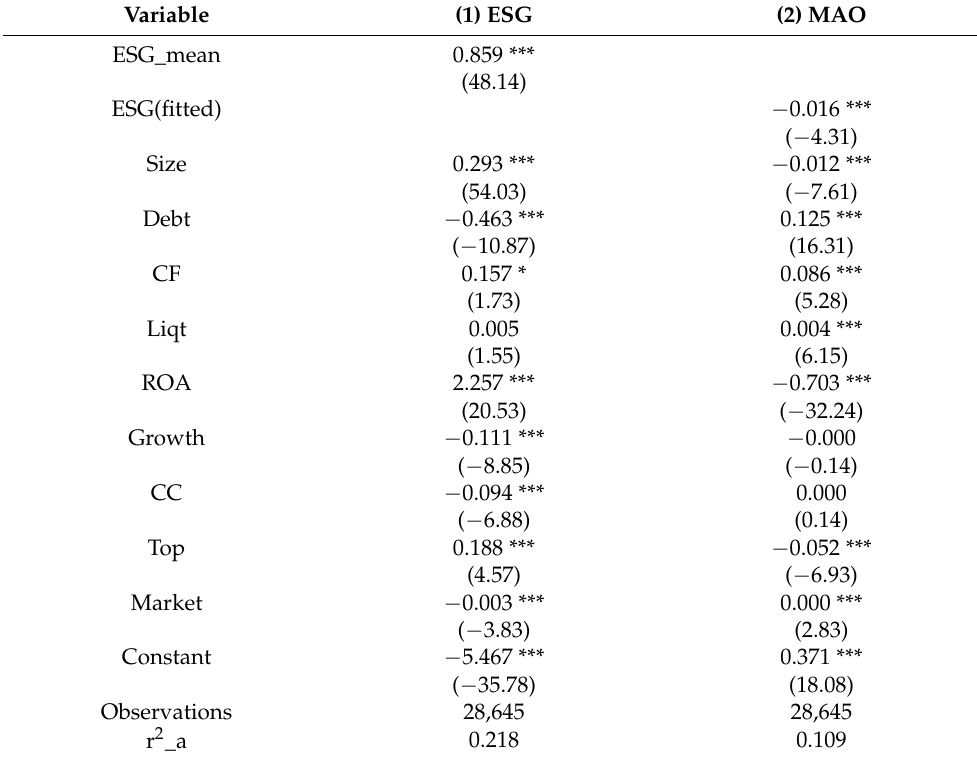
Table 8. Instrumental variable